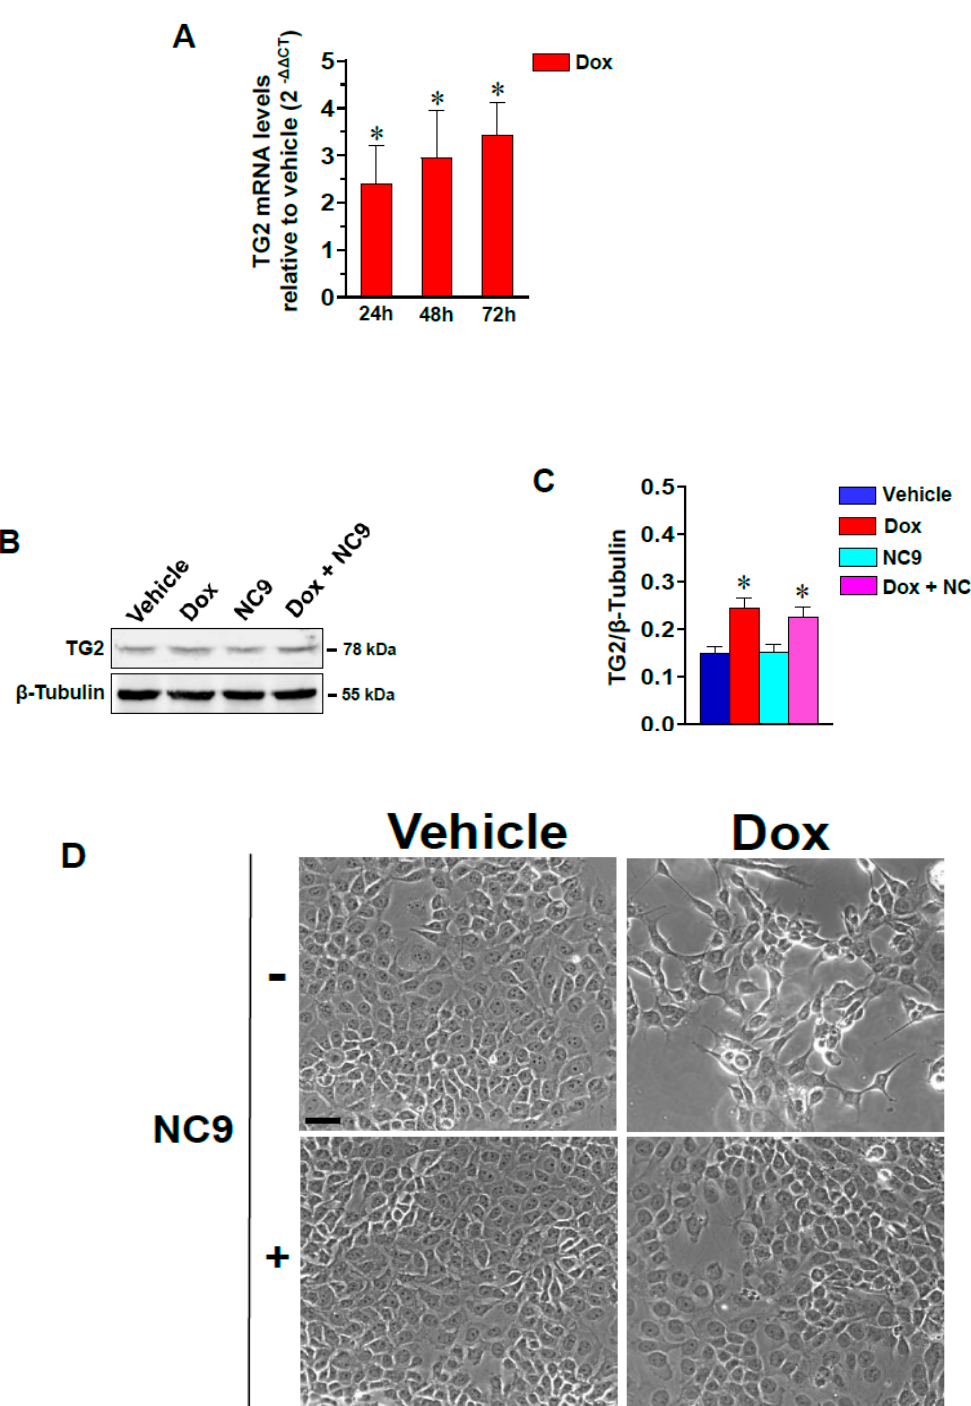
Figure 1. ( A ) RT-qPCR analysis of TG2 mRNA in MCF-7 cells treated with Dox for the indicated time (h). Relative transcript levels were determined using the 2 − ∆∆ CT method and were reported as fold changes with respect to cells cultured in the presence of DMSO (vehicle). ( B ) Representative immunoblot analysis performed with the indicated antibodies on lysates from MCF-7 cells cultured in the presence of vehicle or Dox with or without the addition of the TG2 inhibitor NC9. ( C ) Levels of TG2 as deduced from the chemiluminescence signal normalized with β -Tubulin, which was used as an internal control for the equivalence of loaded proteins. The data are shown as the mean of three separate experiments performed in triplicate ± SD. * p < 0.05 versus vehicle. ( D ) Representative phase-contrast images of MCF-7 cells growing on glass dishes in the presence of vehicle or Dox with or without NC9. Bar = 50 μ m.